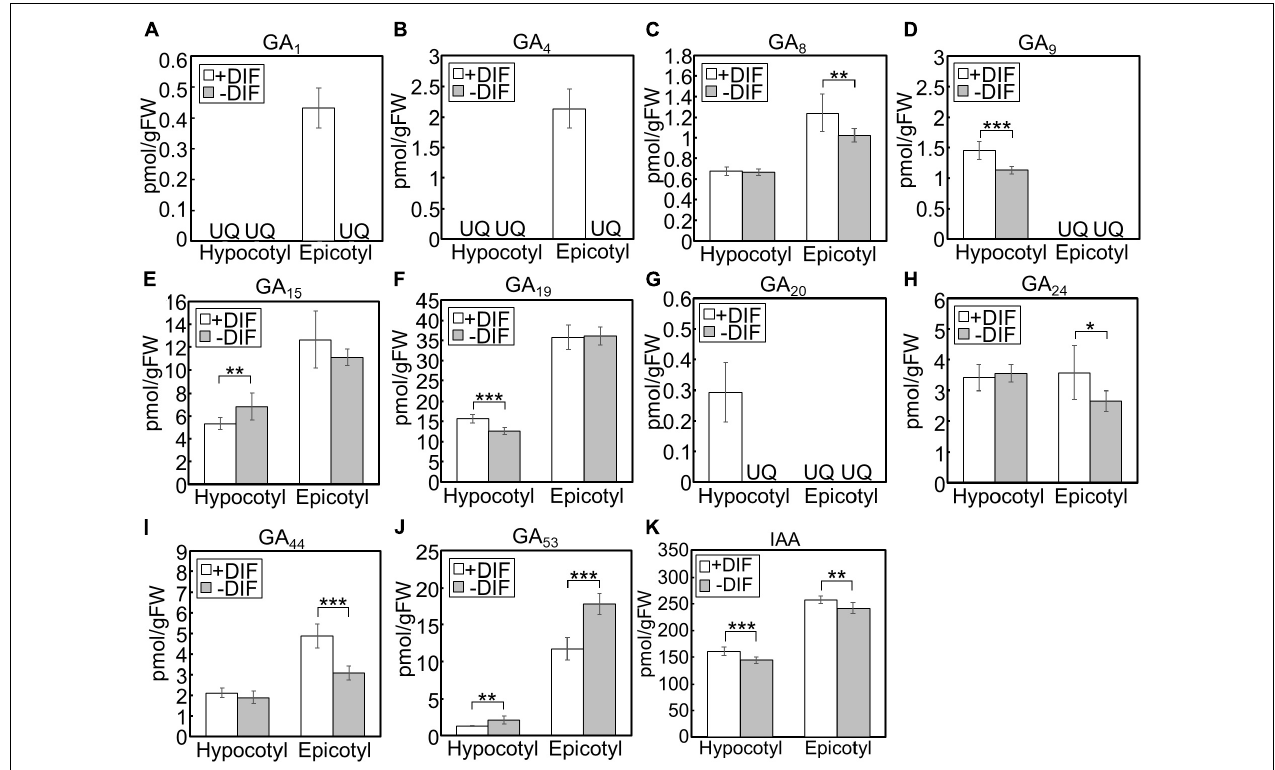
FIGURE 6 | GA and IAA concentration in hypocotyls and epicotyls under negative and positive DIF treatments. Hypocotyls and epicotyls of tomato seedlings grown for 7 days under positive and negative DIF treatments were harvested and subjected to hormone analysis. The concentrations of GAs (A–J) and IAA (K) were quantified using liquid chromatography-tandem mass spectrometry. Data are represented as mean ± SD ( n = 4 or 5). * P < 0.1; ** P < 0.05; *** P < 0.01 (Student’s t test). GA 7 and GA 12 were below the quantification limit. +DIF, positive DIF; -DIF, negative DIF; FW, fresh weight; UQ, under quantification